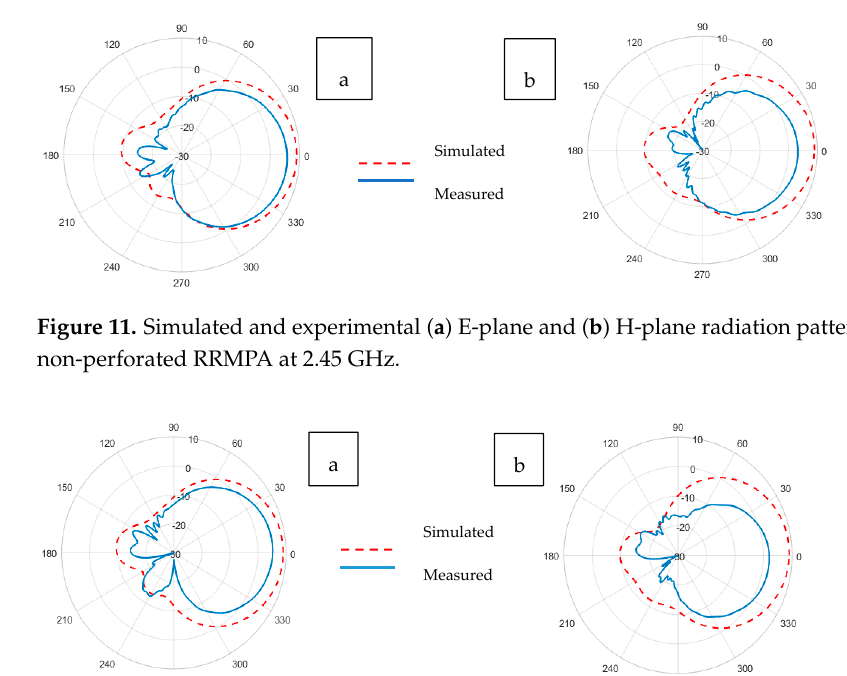
Table 5. Variance analysis results of air permeability tests for non-perforated and perforated antennas.